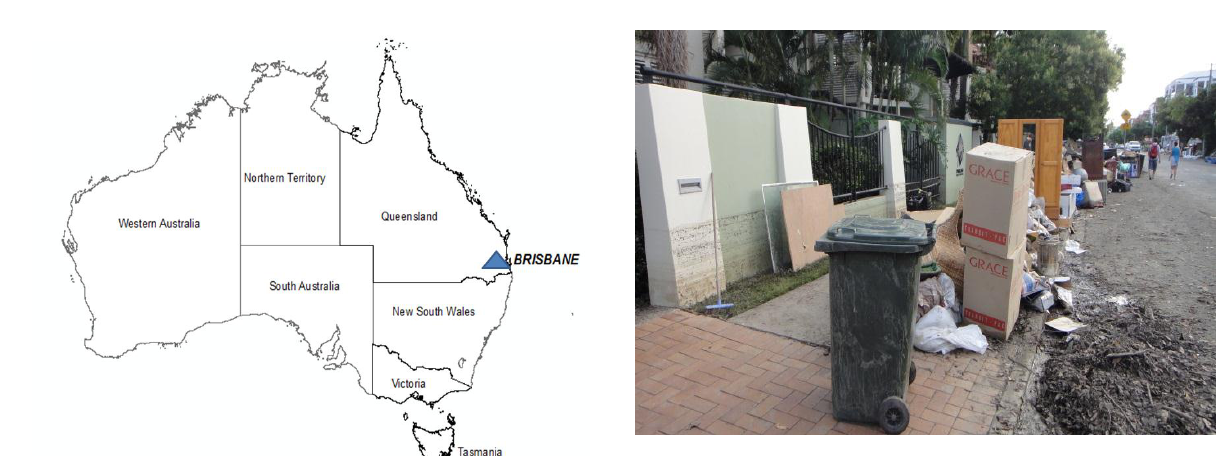
GPS survey to re-create the flood peak.